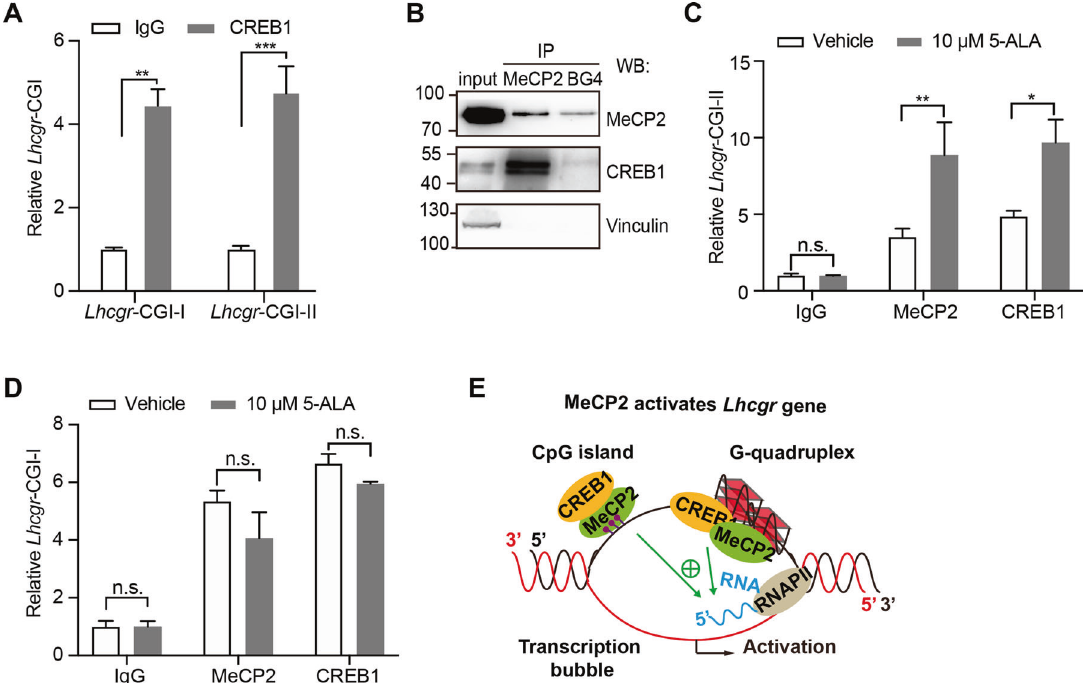
Fig. 5 MeCP2/CREB1 complex binds to Lhcgr G-quadruplex structures and CGIs. A ChIP-qPCR analysis is showing the relative enrichment of CGI-I and CGI-II regions in chromatin from the testis of WT mice using the CREB1 antibodies or control IgG. N = 3 for each group. B Immunoprecipitation assay of BG4-interacting proteins and MeCP2-interacting proteins from TM3 cells transfected with MeCP2 using a BG4 antibody and MeCP2 antibody. The interaction was con fi rmed by western blot with anti-MeCP2, anti-CREB1, and anti-Vinculin. Vinculin was used as a negative control. C , D The relative enrichment of Lhcgr -CGI-II ( C ) or Lhcgr -CGI-I ( D ) in Lhcgr with or without 10 μ M 5-ALA treatment by ChIP-qPCR analysis in TM3 cells. The MeCP2, CREB1 antibodies, or IgG were used, respectively. N = 3 for each group. E Schematic illustration of the mechanism of MeCP2 regulation on Lhcgr . For A , C , and D , data are presented as mean ± s.e.m. * p < 0.05; ** p < 0.01; *** p < 0.001, n.s. represents not signi fi cant. Statistical analyses were performed with One-way